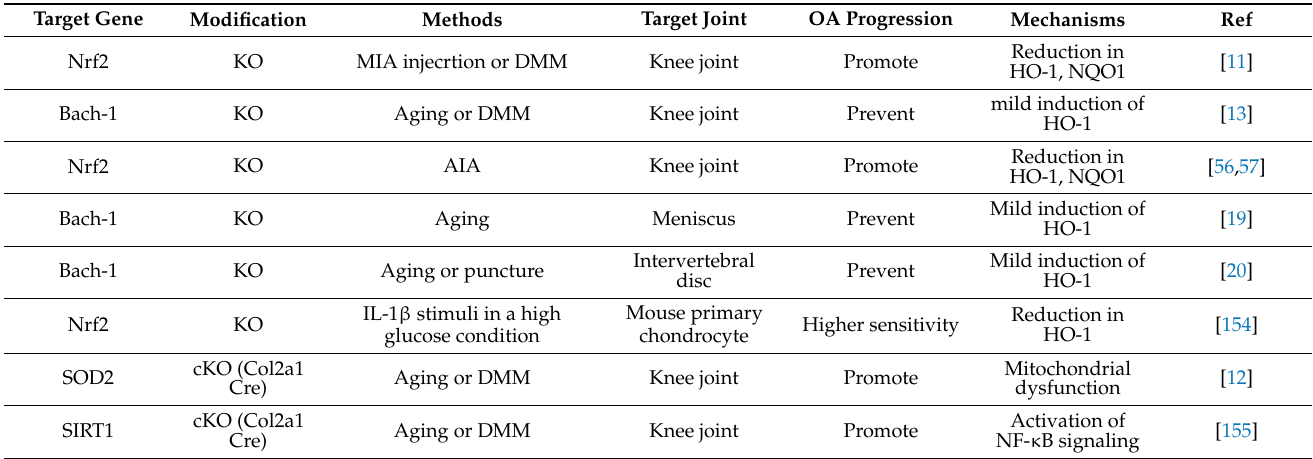
Table 3. List of antioxidants signal-related gene modification